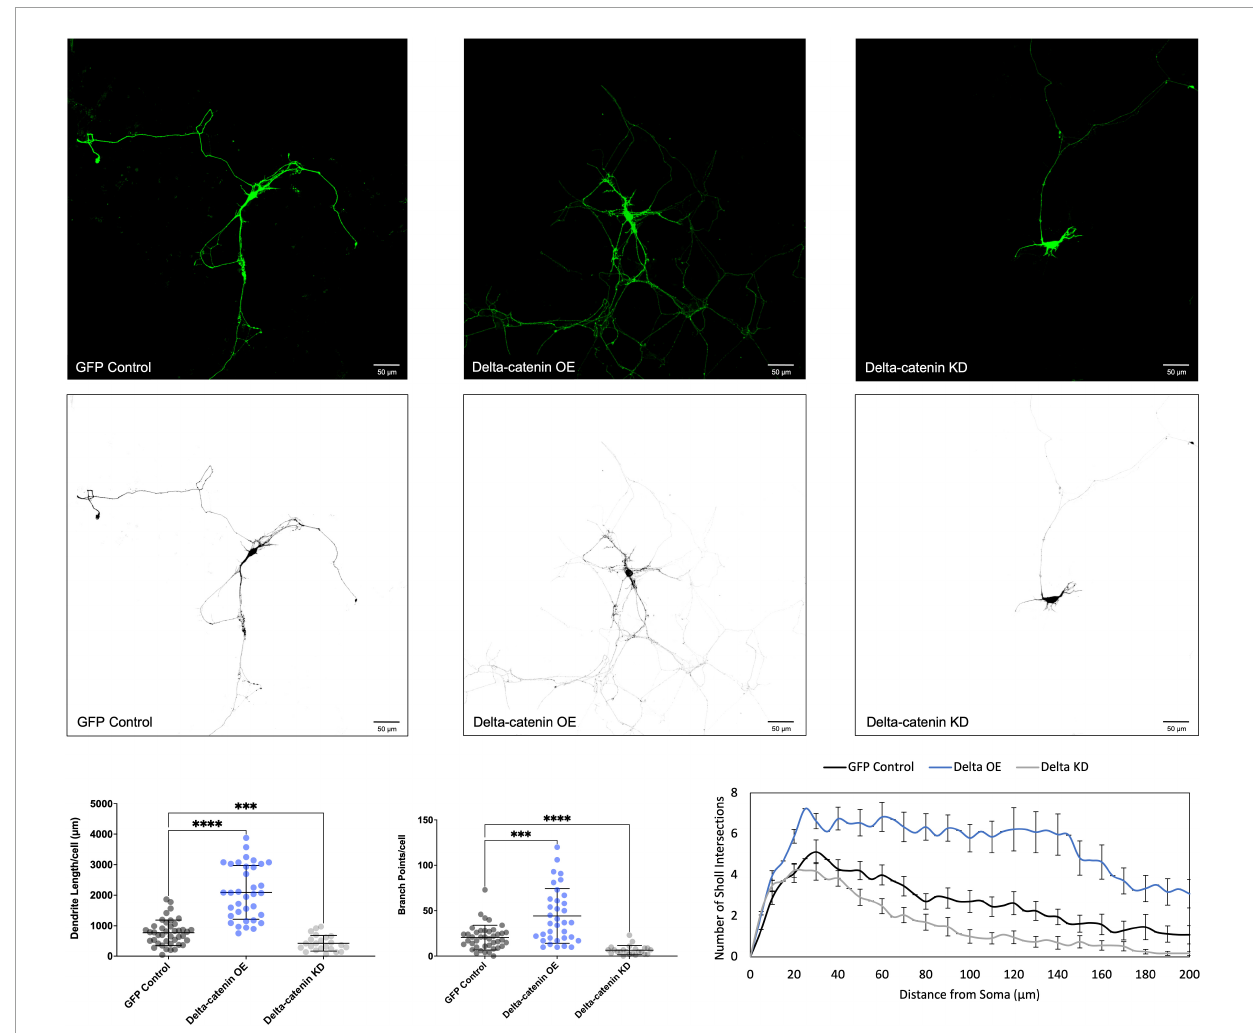
FIGURE4 Morphological effects of delta-catenin expression in developing rat primary hippocampal neurons. Example images are shown of neurons that have been transfected with GFP, exogenous delta-catenin, and shRNA to knockdown delta-catenin. Cells were transfected at 3 DIV and analyzed at 7 DIV. These images have been masked to eliminate other cells in the visual field for clarity. Quantification of the average dendrite length per cell and average number of branch points per cell per each condition are shown below on the left, and Sholl analysis for each condition to the right. The number of cells analyzed in each condition were 35 for delta-catenin OE, 23 for delta-catenin KD, and 41 for GFP control. Samples were taken from five biological replicates. Statistical significance was determined using a two-way Brown-Forsythe and Welch ANOVA tests with Dunnett’s T3 multiple comparisons post-hoc test. Significance was assigned at P < 0.001 for *** and P < 0.0001 for ****. Chart values show mean and standard